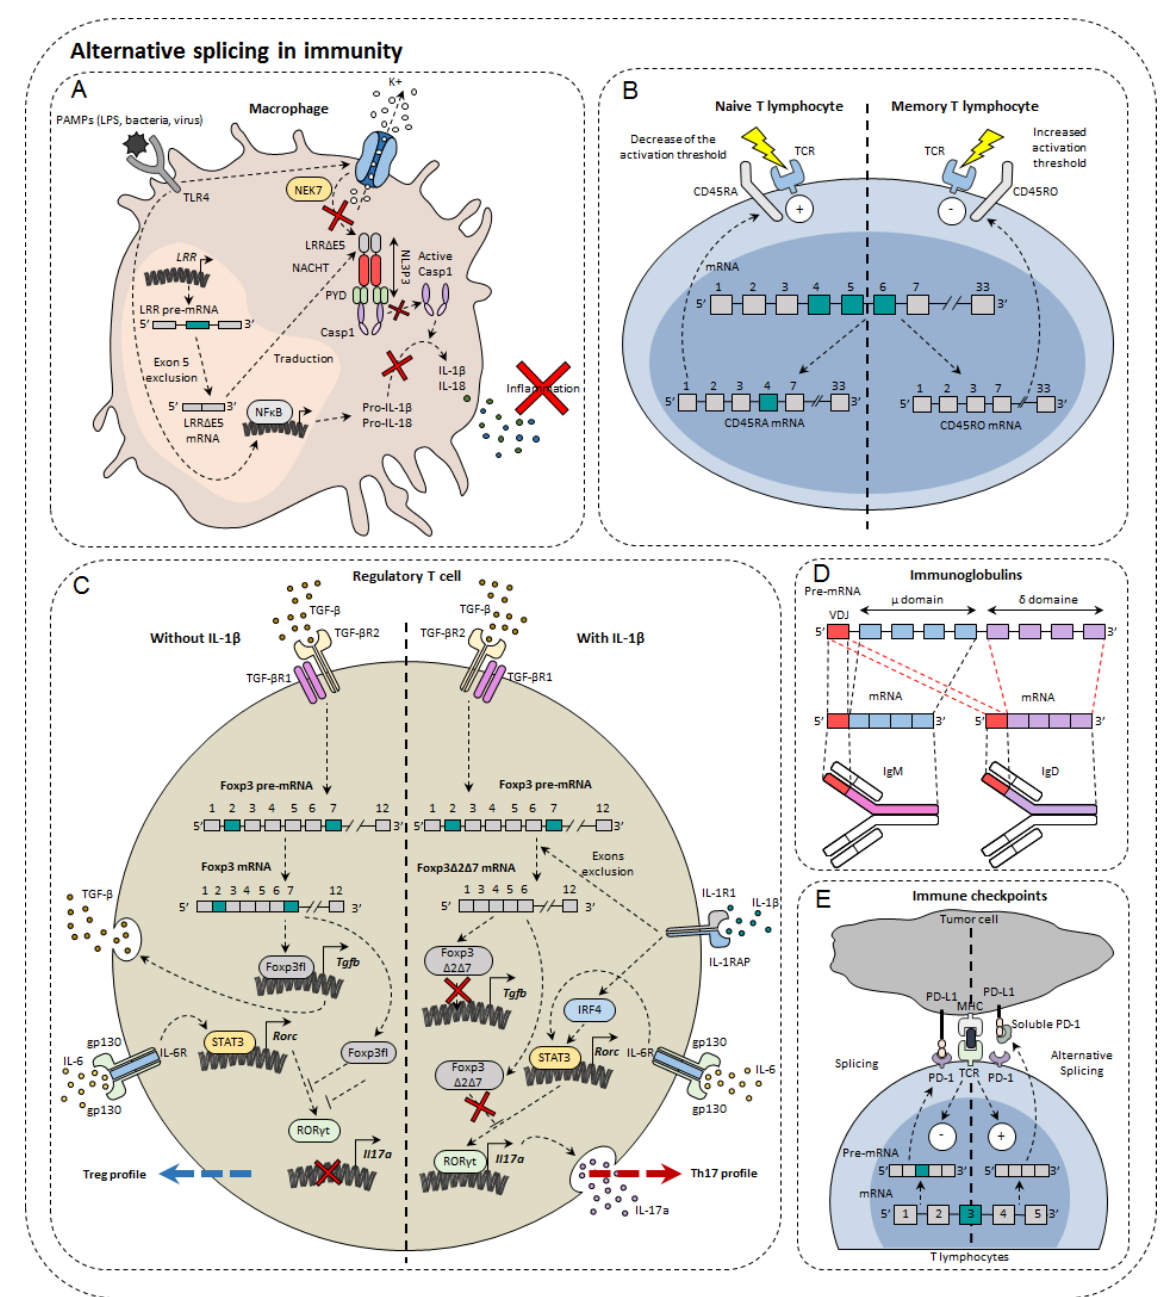
Figure 2. Alternative splicing in immunity. Alternative splicing has a direct impact on normal immune cells such as macrophages ( A ), T lymphocytes ( B ), regulatory T cells ( C ), immunoglobulin diversity ( D ), and immune checkpoints ( E